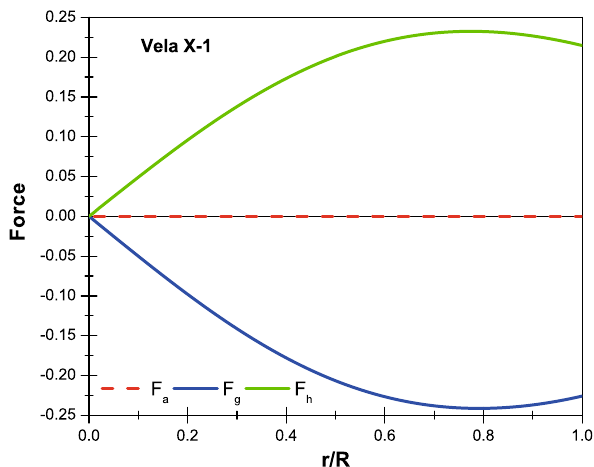
Fig. 19 Behaviour of adiabatic index versus the dimensionless radius for α = 0 . 3